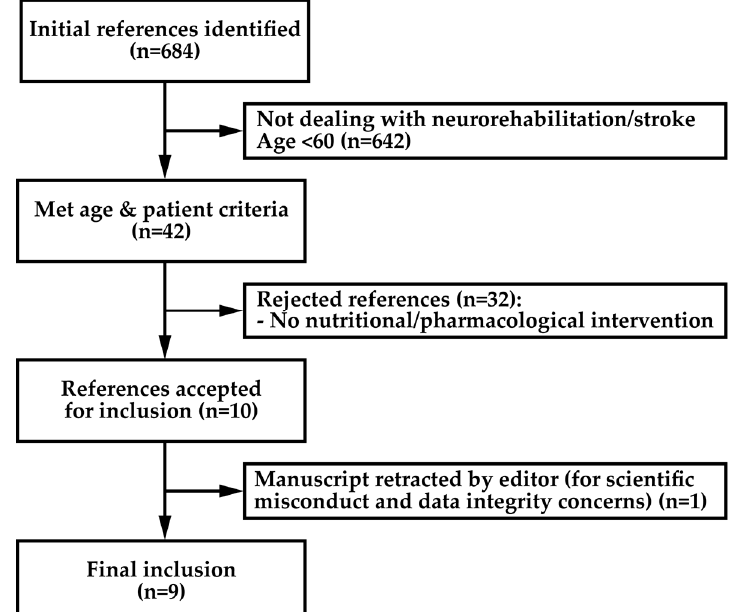
Figure 1. Flow chart of studies selection process.